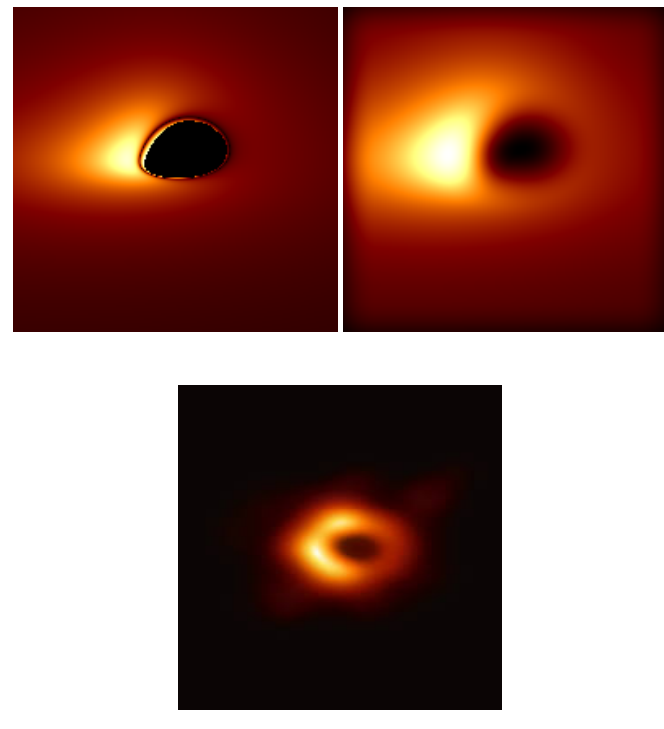
Figure 5. Infinite, counterclockwise rotating geometrically thin accretion disc around static rotating compact objects viewed from an inclination of 70 ◦ . The upper row and the left panel show the result for a resolution of 0.5 µ as while the right panel corresponds to a resolution of 20 µ as . In the upper row, a = 0.6 m 0 . The lower figure is taken from the EHT results, rotated by 90 ◦ . The figures were obtained using the open accessible 2014 version of the GYOTO routines [48]. For n = 4, the modified C++ routines can be retrieved in